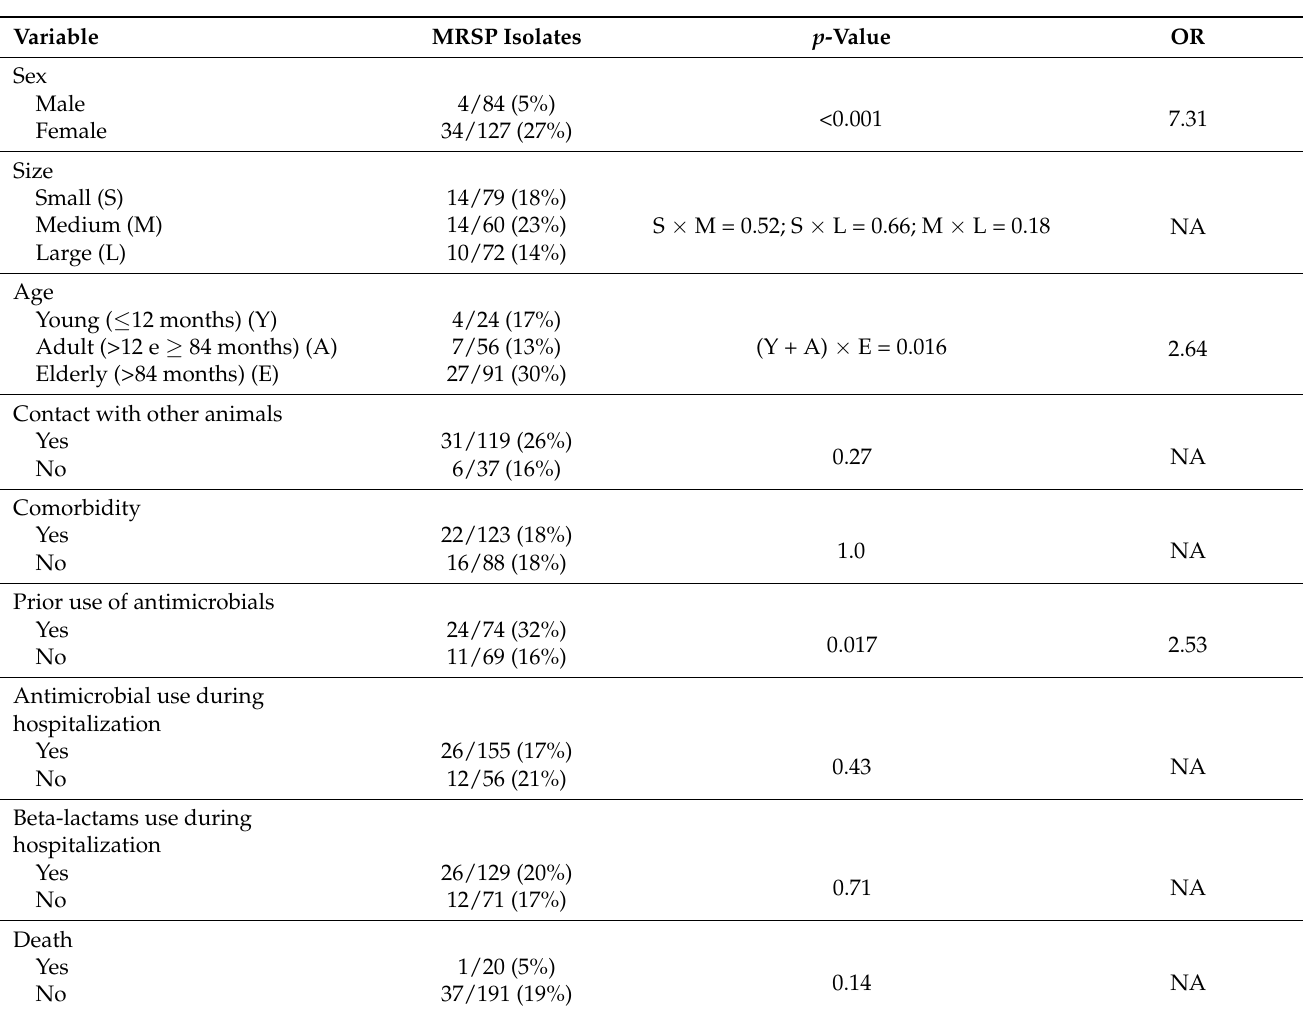
Table 4. Variables evaluated as possible risk factors associated with MRSP in the ICU of HV-UFMG between August 2018 and April